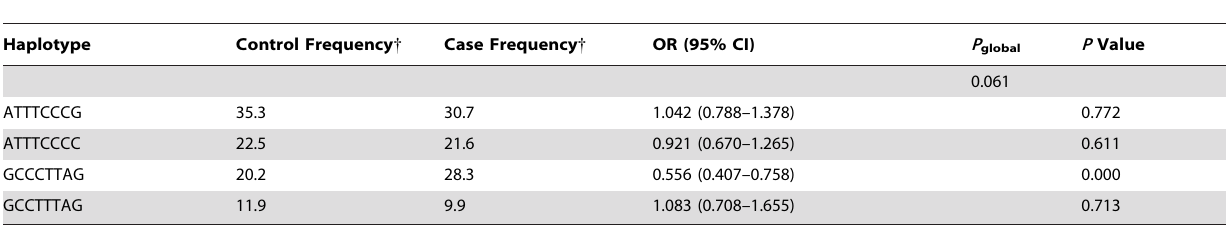
Table 4. Association of haplotypes in TLR4 with hepatocellular carcinoma.